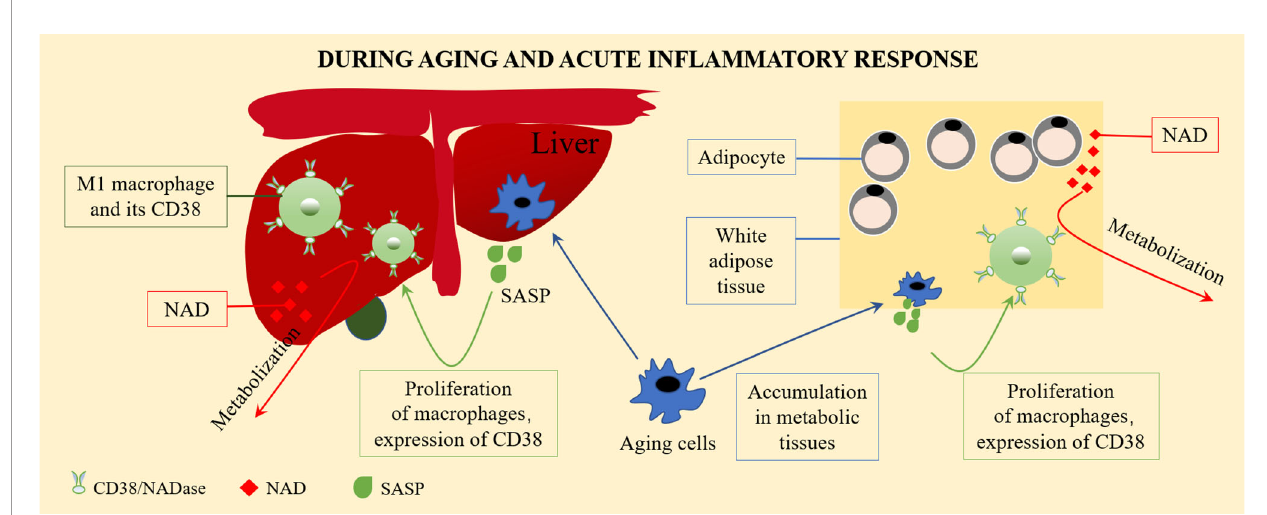
FIGURE 1 | The CD38 expression on macrophage and the regulation of NAD + level. Aging cells gradually accumulate in visceral white adipose tissue and liver during aging. In fl ammatory cytokines secreted by aging cells (senescence associated secretory phenotype, SASP) induce macrophages to proliferate and to express CD38. Pro-in fl ammatory M1-like macrophages accumulate in metabolic tissues, including visceral white adipose tissue and the liver, during aging and acute in fl ammatory responses. These M1-like macrophages express high levels of the NAD-consuming enzyme CD38 and enhanced CD38-dependent NADase activity, thus reduces tissue NAD